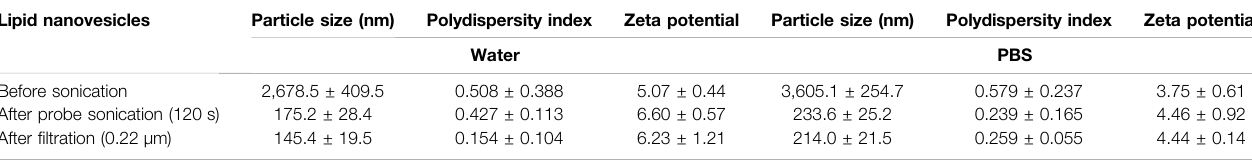
TABLE 1 | Particle size distribution of lipid nanovesicles of voriconazole ( n (cid:2) 3). Lipid nanovesicles